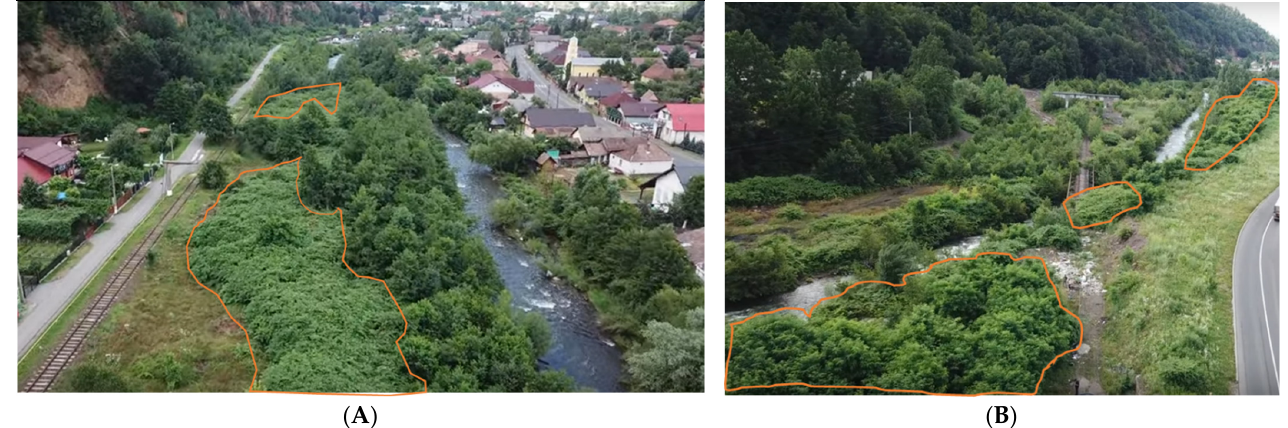
Figure 2. Reynoutria japonica Houtt. occurrence in Ferneziu ( A ), and Romplumb ( B ) sites. The areas marked with an orange line represent the area covered by RJ. (Source: Original).